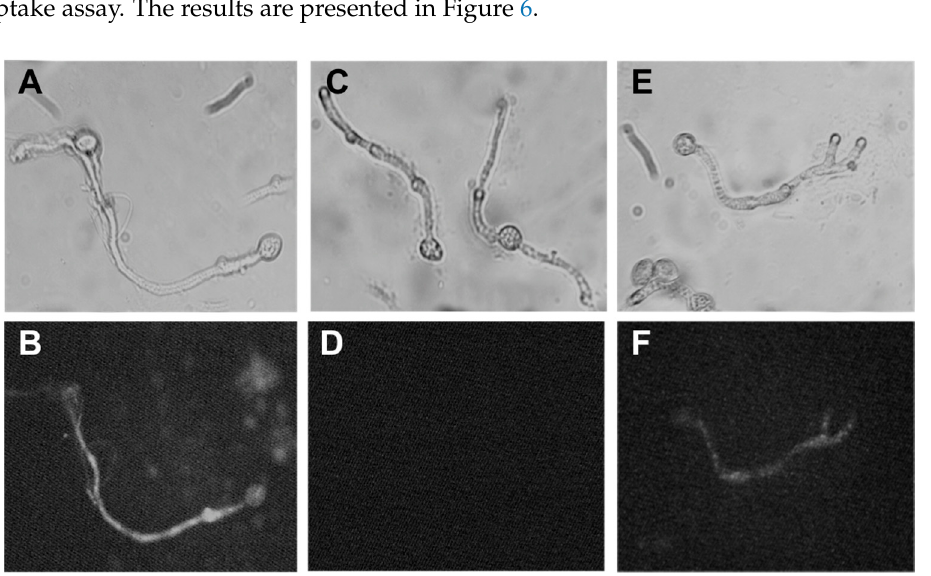
Figure 6. Effect of polygodial on membrane integrity of B. cinerea . Conidia (1 × 10 5 conidia/mL) were incubated in liquid minimum medium in the presence of ( A , B ) 70% ( v / v ) ethanol, positive control; ( C , D ) methanol, negative control; ( E , F ) polygodial at 117 ppm, respectively for 1 h. The fluorescence of B. cinerea hyphae stained with SYTOX Green was observed using a fluorescence microscope. These photographs are representatives of five independent experiments.